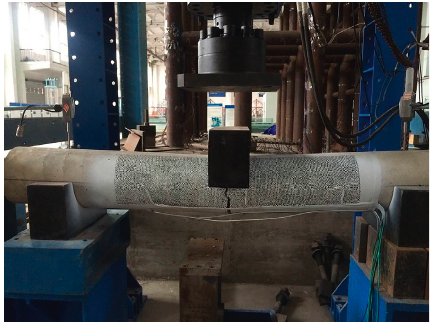
Figure 9: Brittle failure of reinforced